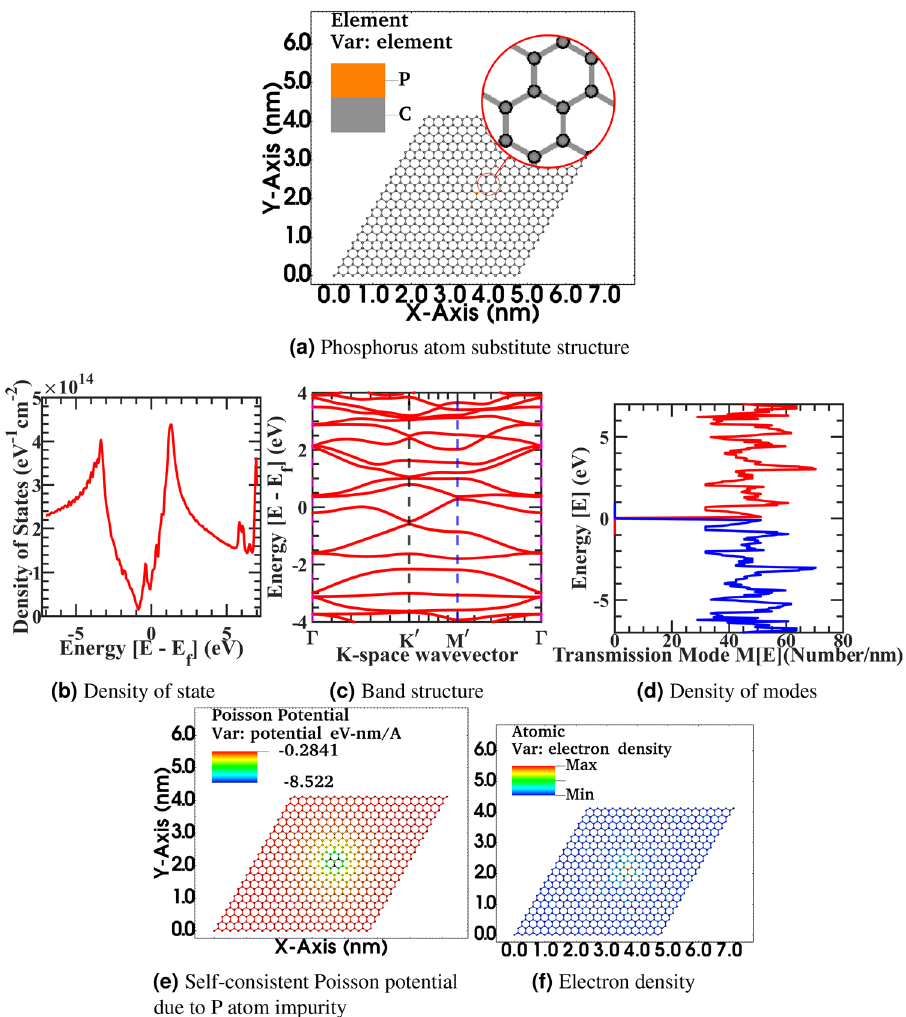
Figure 8. Primitive device structure 20 x 20 graphene supercell with substitutional phosphorus impurity with ten electronic charge ( a ), Density of state ( b ), Electronic band structure ( c ), Density of modes ( d ), Self- consistent Poisson potential due to Phosphorus impurity ( e ), Electronic density ( f